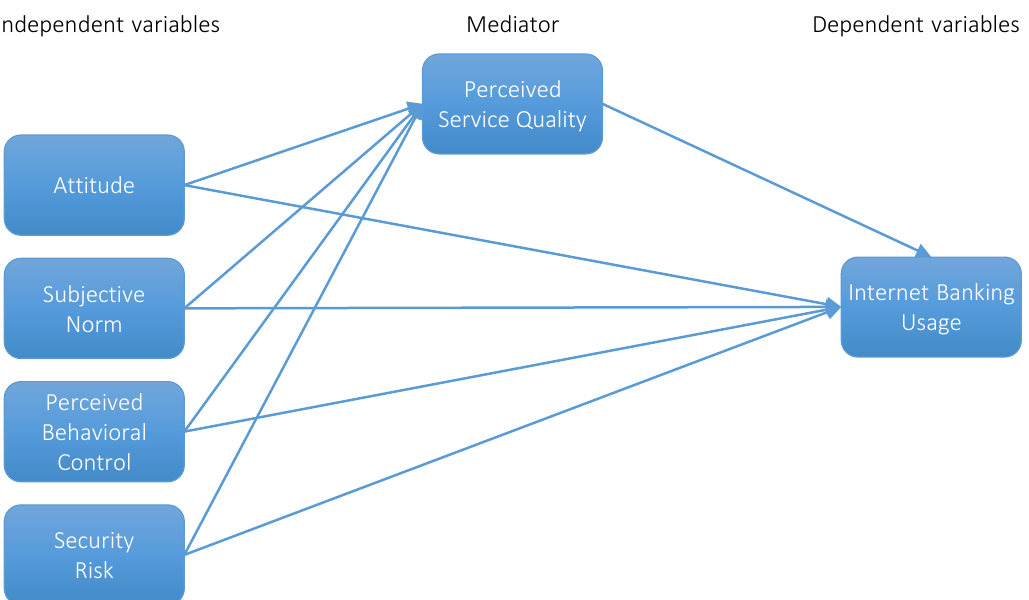
Figure 1. Conceptual model of the determinants of Internet Banking